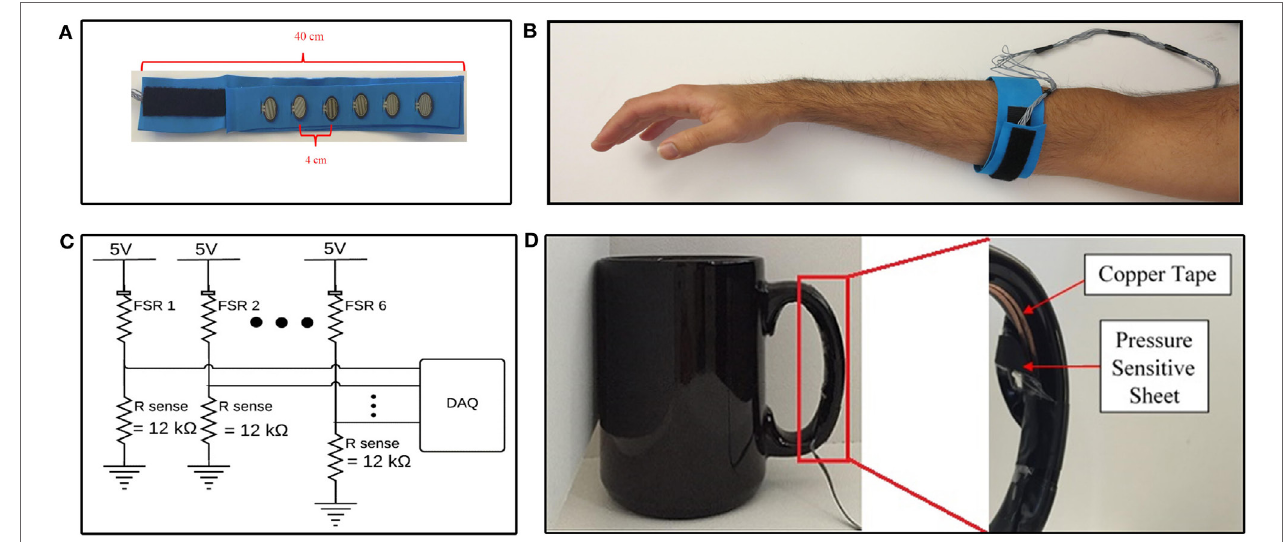
FigUre 1 | Data acquisition devices and systems. (a) Internal view of force-sensing band. (B) Force-sensing band donned on forearm. (c) Data acquisition system. (D) Internal view of validation sensor on cup